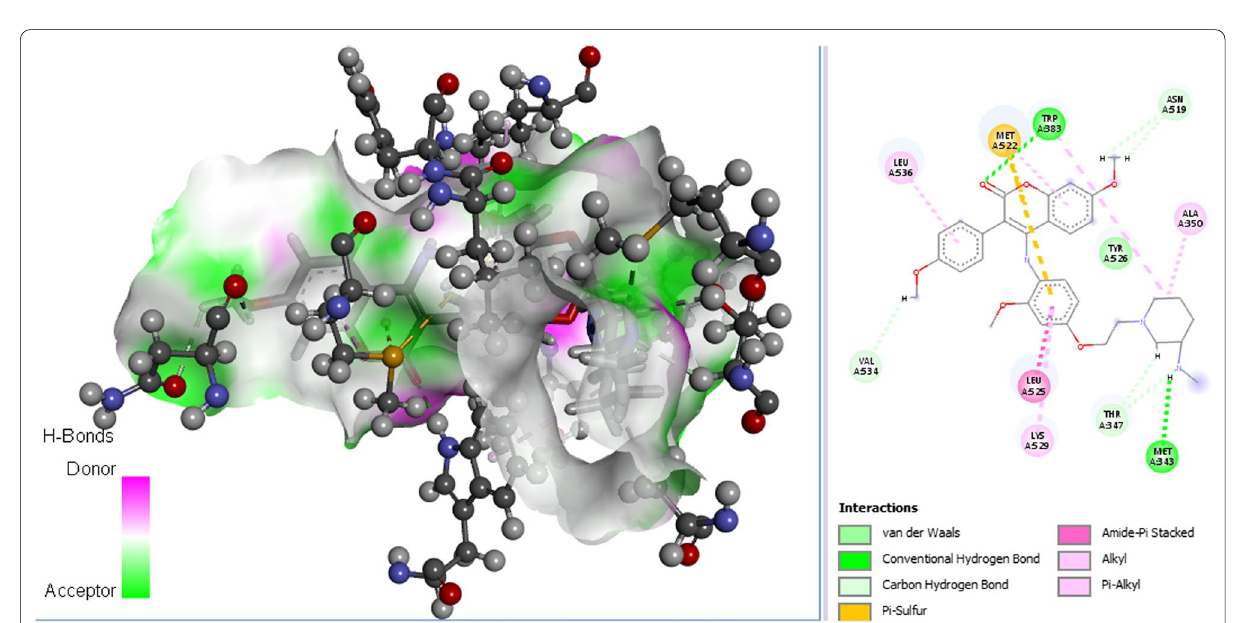
Fig. 13 3D and 2D interactions of designed compound 11 with the binding site of the ER +